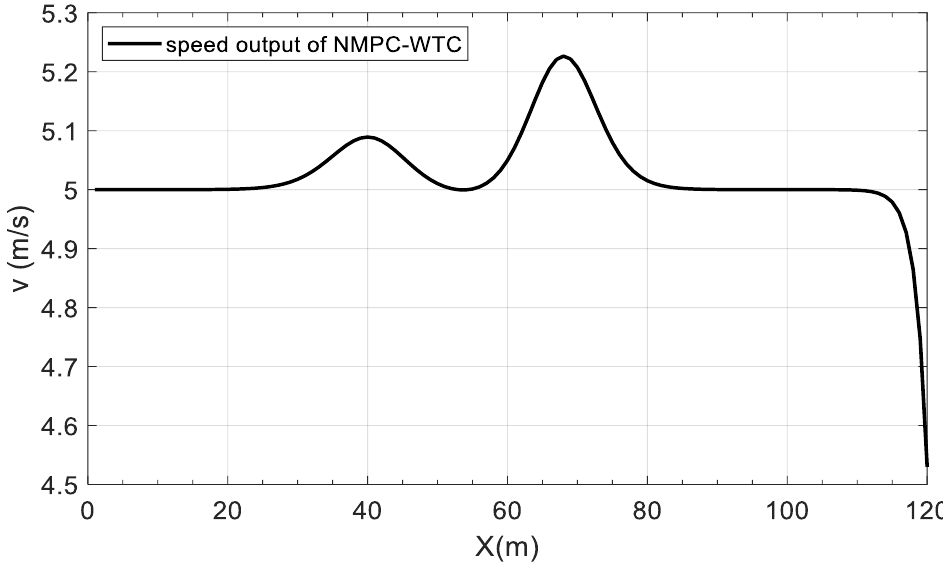
Figure 8. Speed output of proposed NMPC – WTC path tracking method.